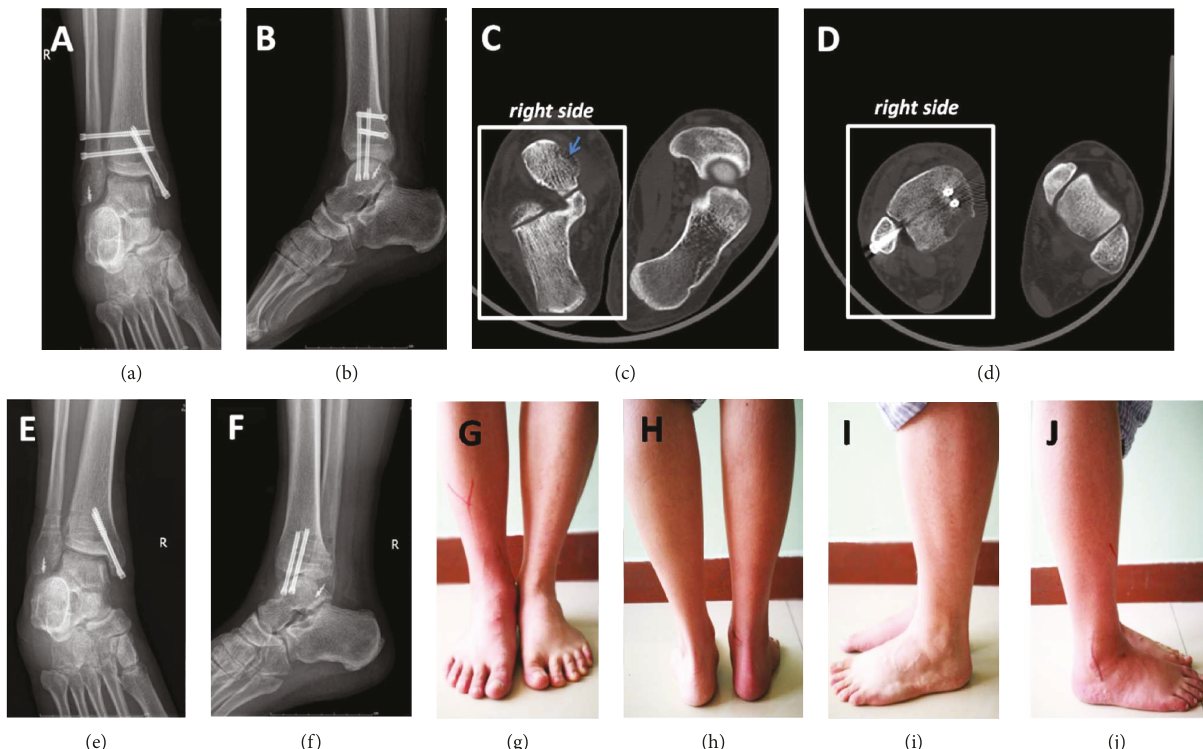
Figure 5: 3 months posttreatment: anteroposterior and lateral radiograph images, radiographs after the removal of the syndesmosis screw fi xation images, CT scanning of the ankle, and images of the patient standing on his feet. (a) Anteroposterior radiograph of the right ankle. (b) Lateral radiograph of the right ankle. (c) The astragalus contusion is indicated with the arrow. (d) The Dupuytren fracture and dislocation was ameliorated. (e) Anteroposterior radiograph of the right ankle after the removal of the syndesmosis screw fi xation images. (f) Lateral radiograph of the right ankle after the removal of the syndesmosis screw fi xation images. Images of the patient standing on his feet. (g) Anteroposterior image of the patient standing on his feet. (h) Posteroanterior image of the patient standing on his feet. (i) Lateral image from the left of the patient standing on his feet. (j) Lateral image from the right of the patient standing on his